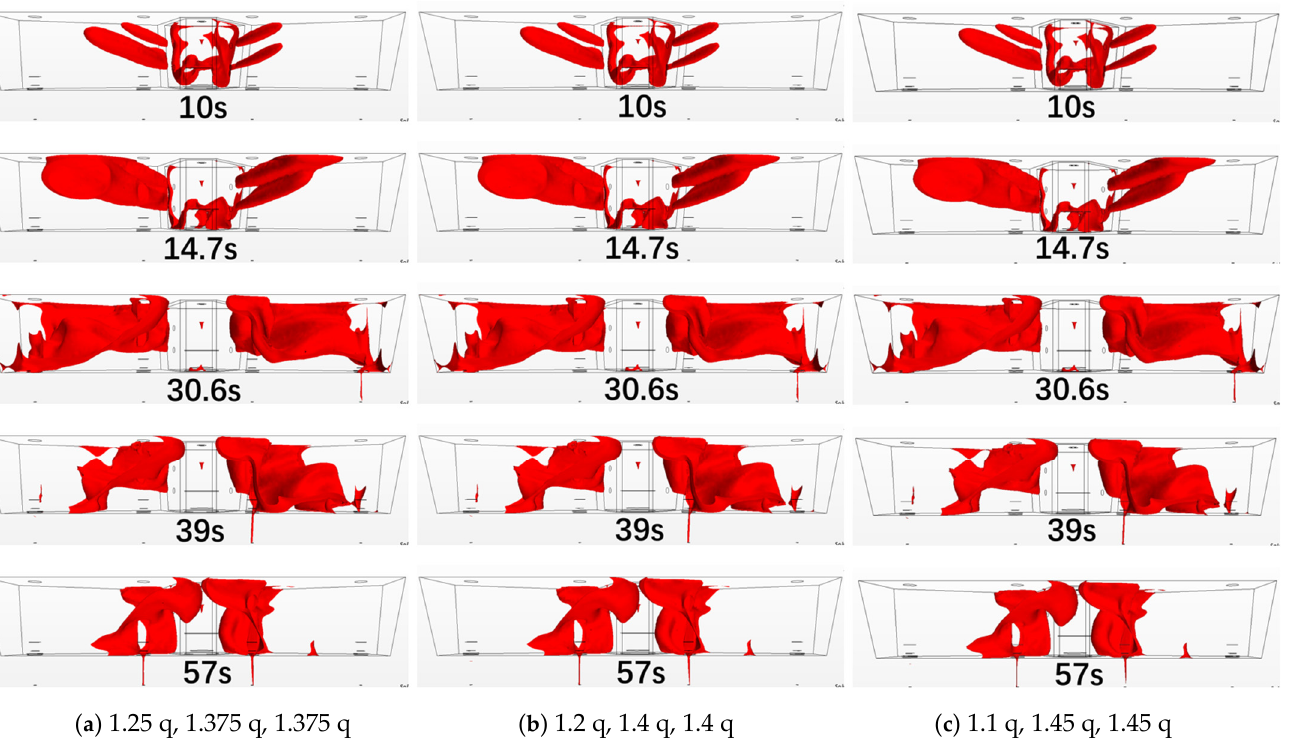
Figure 25. Isosurface evolution results of the u-shaped weir tundish with non-uniform increasing casting flow rate under strand 1 blockage condition ( ω = 10 − 5 ).